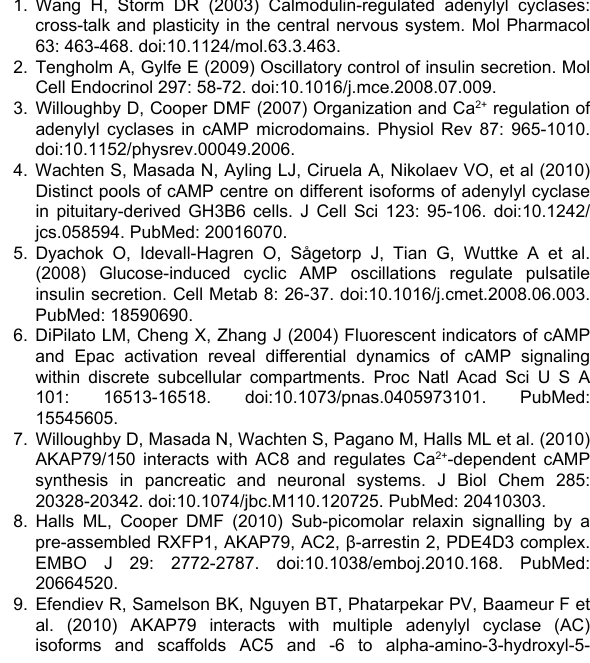
Figure S2. Control data for nifedipine imaging. HEK293 cells ( A ) loaded with fura-2 or ( B ) without fura-2 were imaged at 340 nm and 380 nm and the ratio calculated. 10 µM nifedipine was added for 60 s. n=197 (fura-2) or 91 (no fura-2) cells from three independent experiments.